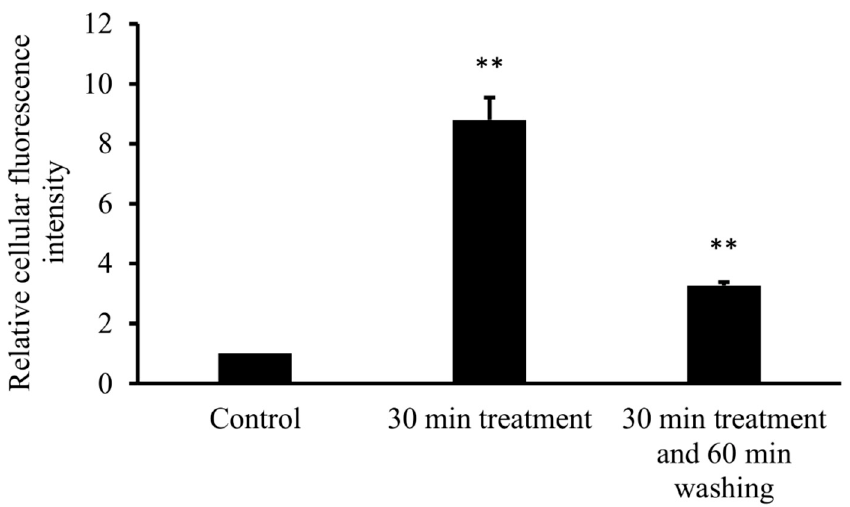
Figure 6. Flow cytometric analysis of FITC-HPBCD uptake in HUVECs. Incubation of HUVECs for 30 min with 50 µM of FITC-HPBCD significantly increased the cellular fluorescence and a following 60 min washing with HBSS decreased it. (Data are expressed as means ± SD, n = 3, significance is expressed as ** p <